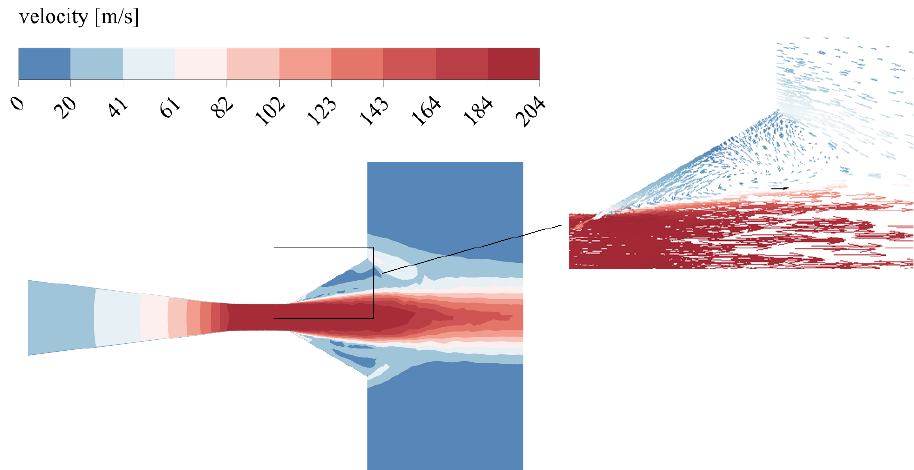
Figure 11. Velocity distribution of the angular cavitation nozzle.